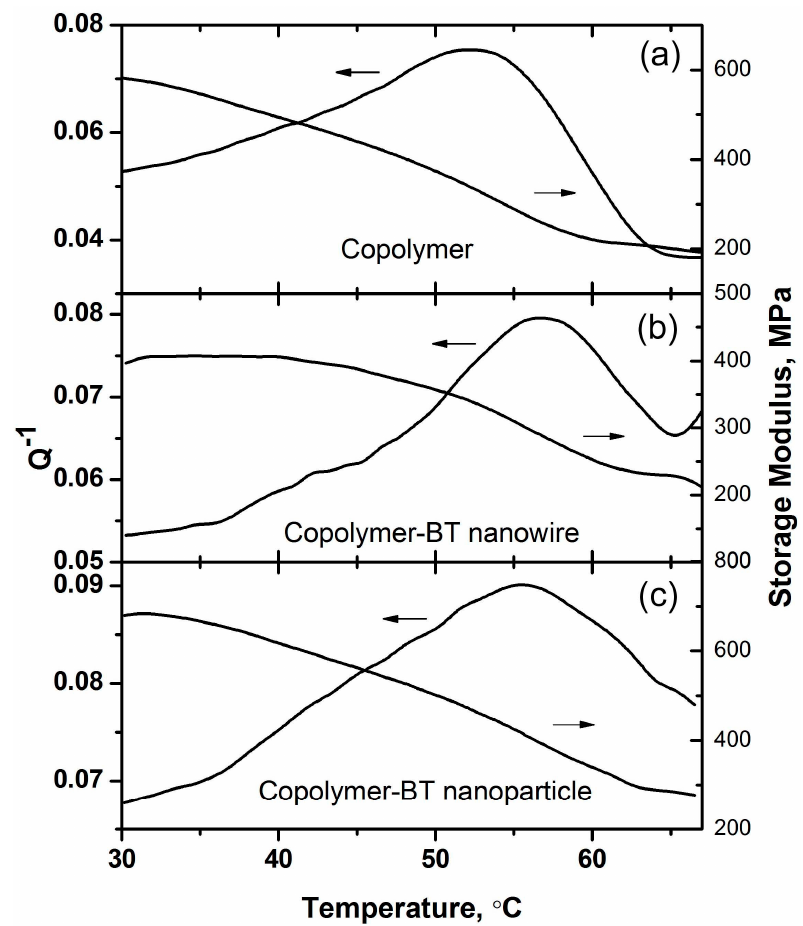
Figure 7. The effects of nanofiller geometries on the mechanical loss and storage modulus (at 1 Hz) of P(VDF–TrFE)–BT nanocomposites. ( a ) Copolymer; ( b ) Copolymer-5% BT nanowires; ( c ) Copolymer-5% BT nanoparticles.